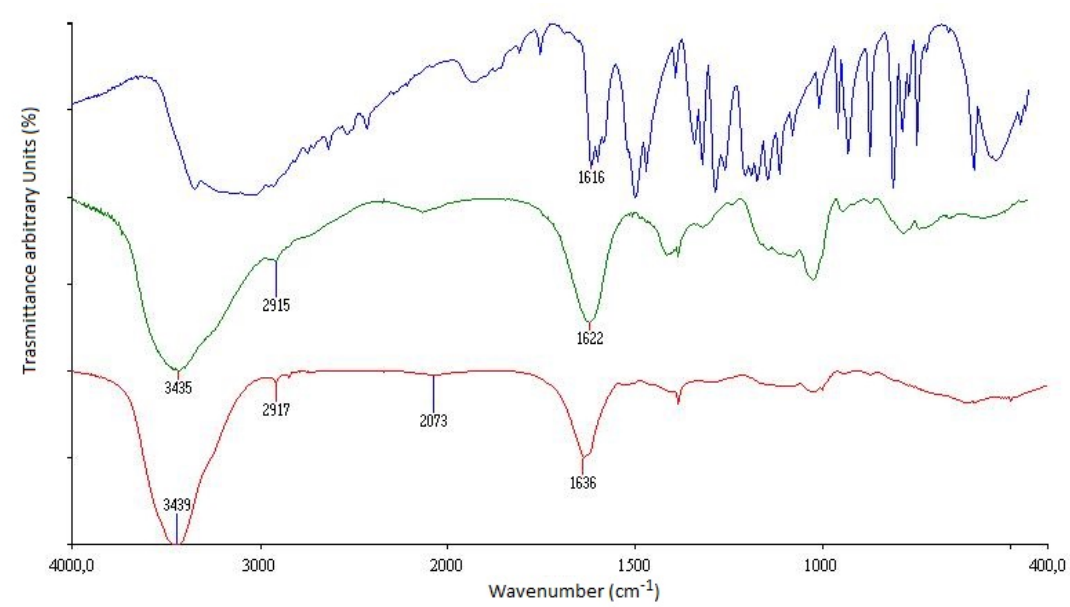
Figure 6. FT-IR spectra of pure DA (blue); pure Alg OX (green); and Alg OX-DA (pink). As can be seen, in the spectrum of AlgOX, the band corresponding to the aldehyde vibration was not detected.